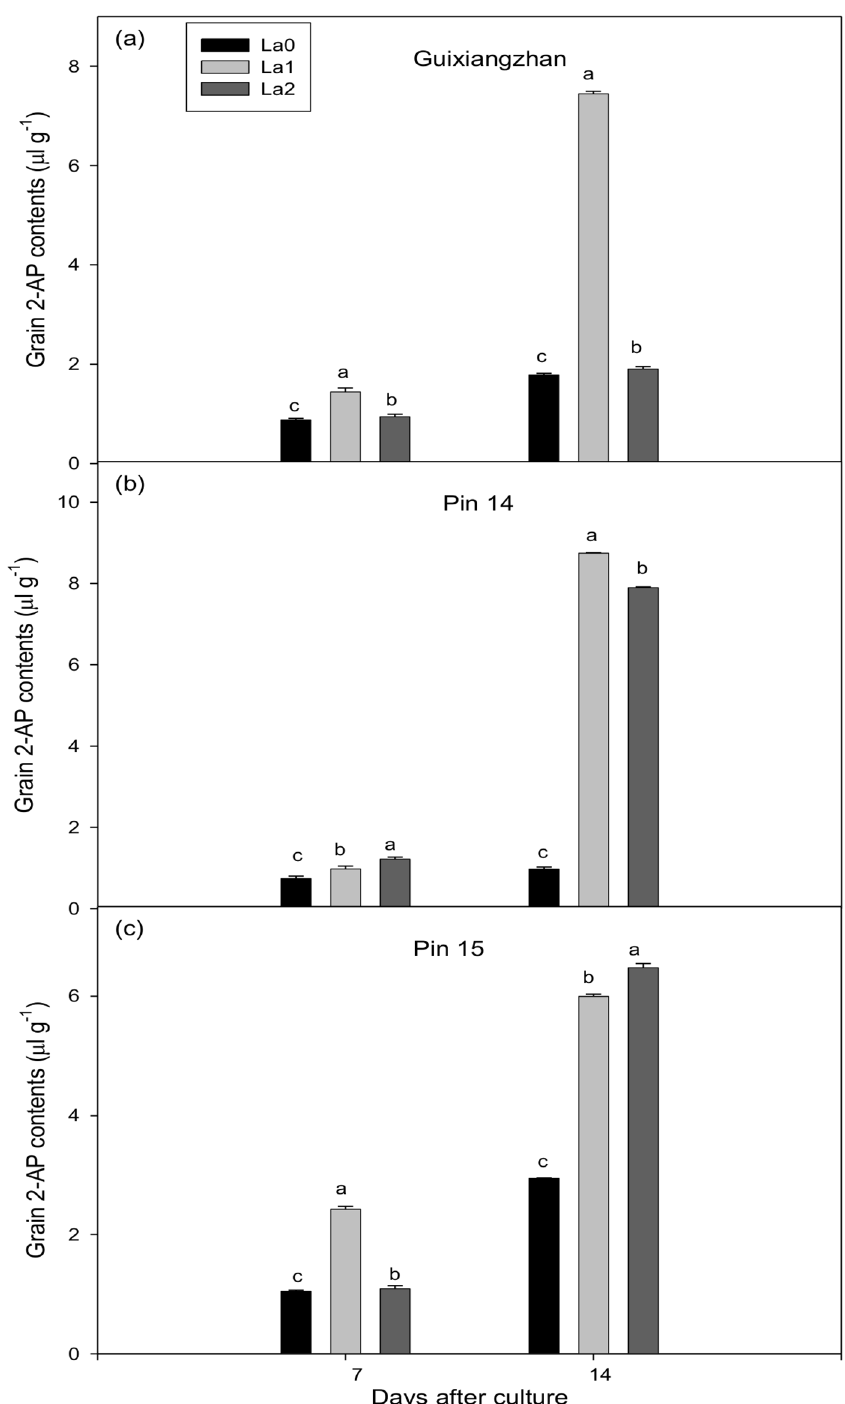
Fig 3. Effect of La supplementation on accumulation of 2-AP concentrations ( μ l g -1 ) in grains of detached aromatic rice panicles in vitro . Means in the same harvest stage with different lower case letters for the same variety differ significantly (P (cid:2) 0.05) according to the DMR test. Capped bars above the means represent the S.E. of three replicates.